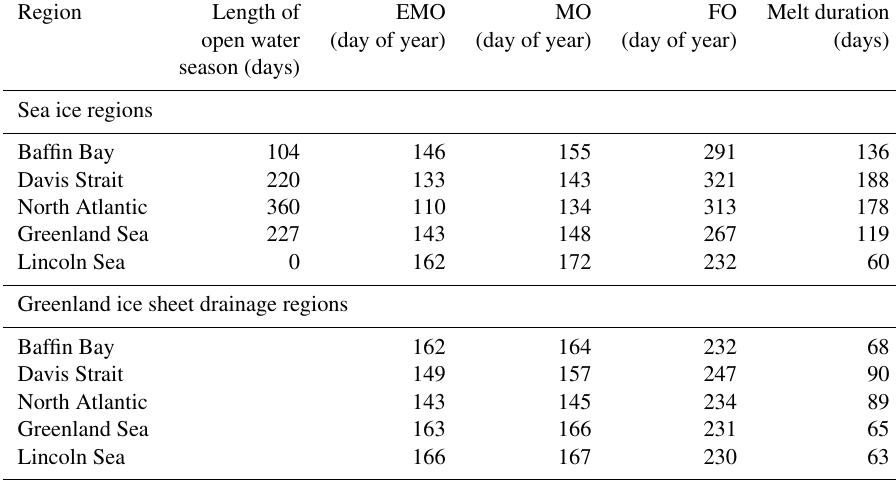
Table 1. Climatological (1981–2010) mean values in length of open-water season, together with climatological dates in early melt onset (EMO), continuous melt onset (MO), continuous freeze-up (FO), and melt season duration for five sea ice regions (excluding the North Atlantic where little sea ice exists). Corresponding mean dates in MO, FO and duration are also shown for the Greenland drainage basins. Region Length of EMO MO FO Melt duration open water (day of year) (day of year) (day of year) (days) season (days) Sea ice regions Baffin Bay 104 146 155 291 136 Davis Strait 220 133 143 321 188 110 Greenland Sea 143 Greenland ice sheet drainage regions Baffin Bay